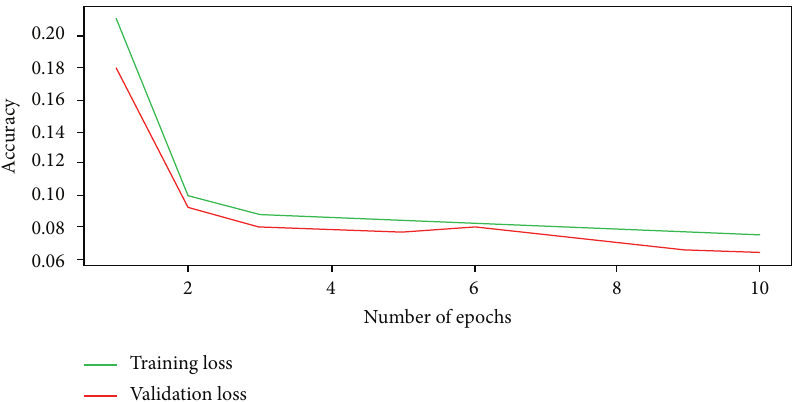
Figure 13: Training loss and number of epochs of the convolution neural network long short-term memory (CNN-LSTM) model.